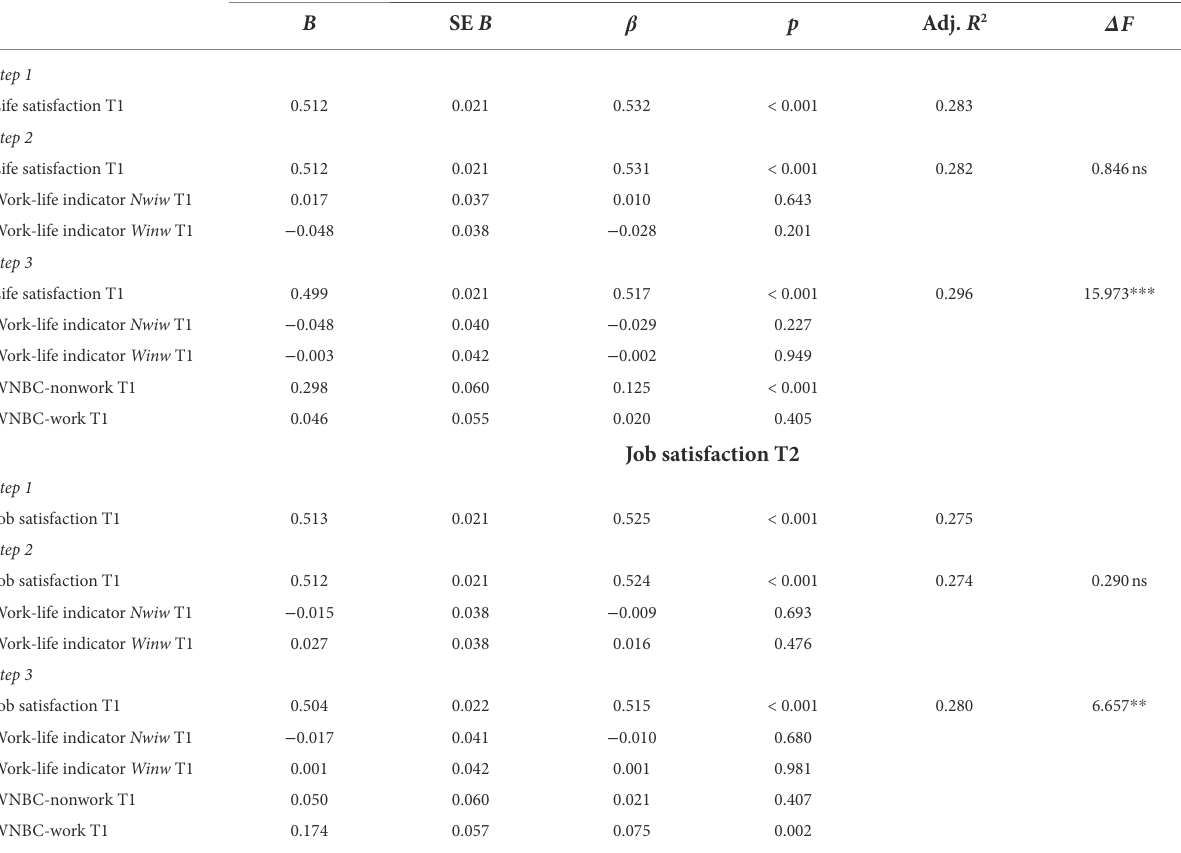
TABLE 4 Hierarchical regression analyses with predictors of job/life